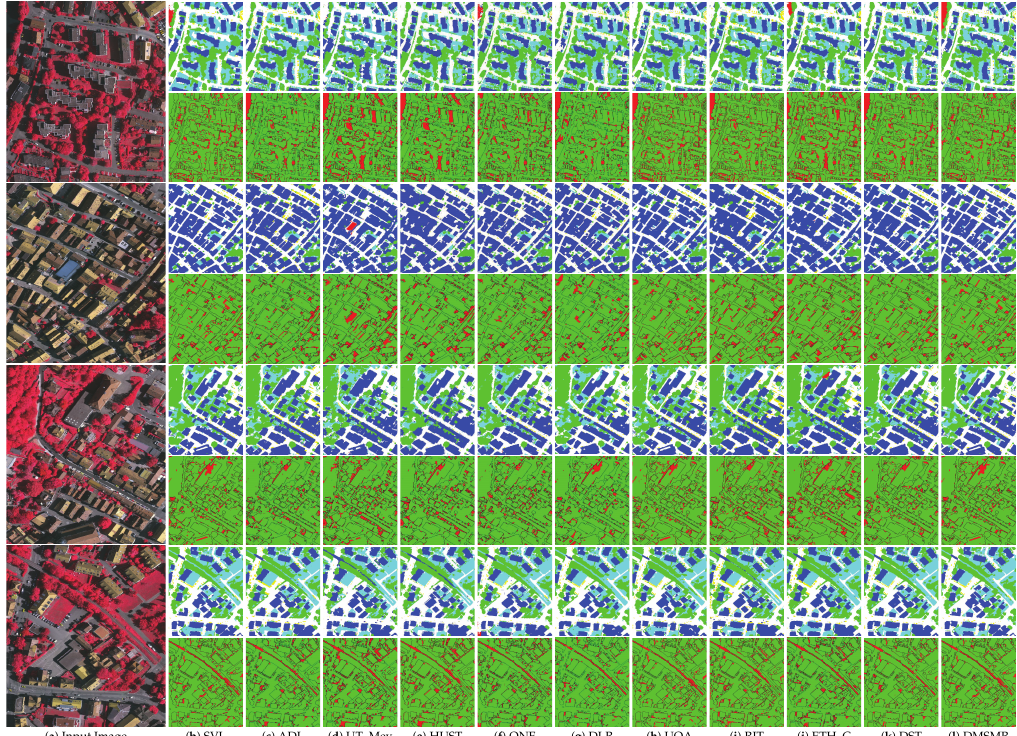
Figure 6. Visualization of the comparative results on a few Vaihingen testing imagery (tile numbers 2, 4, 6 and 8). For each image, we generate the dense prediction results and corresponding error maps (red/green image) with different